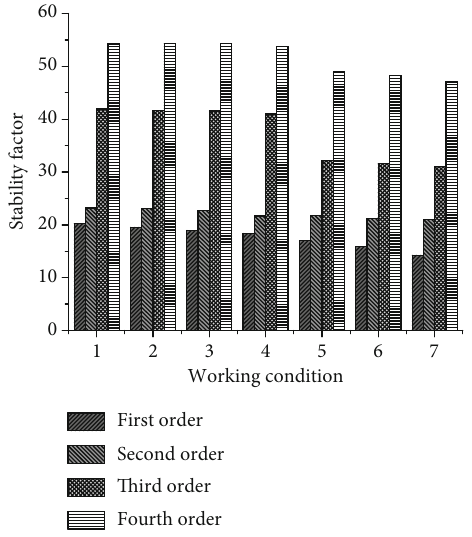
Figure 9: Variation of bridge stability coe ffi cient under di ff erent working